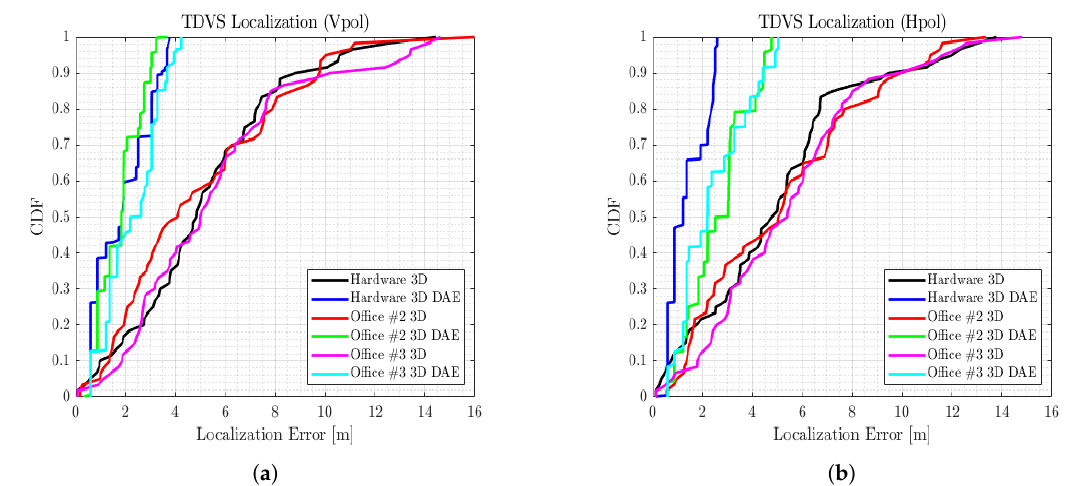
Figure 15. CDF localization performance for the TDVS and TDVS-DAE based algorithms for ( a ) vertical transmitter polarization and ( b ) horizontal transmitter